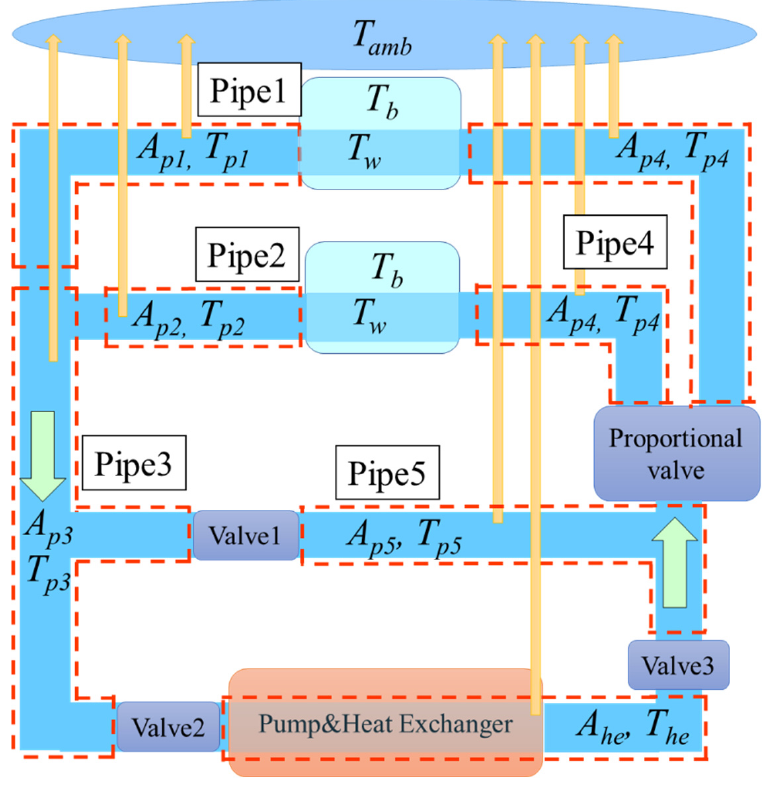
Figure 3. Decomposition of the HTMS.